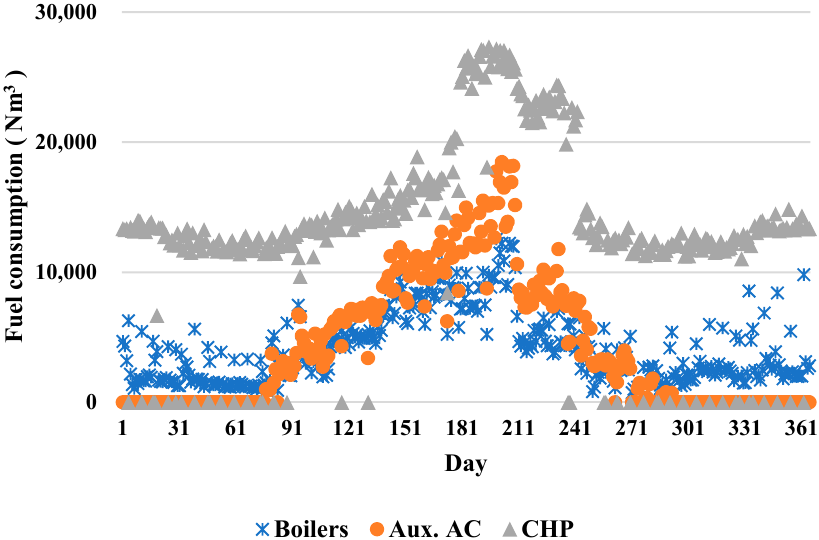
Figure 3. Annual daily fuel consumption profile for each facility for Case A.